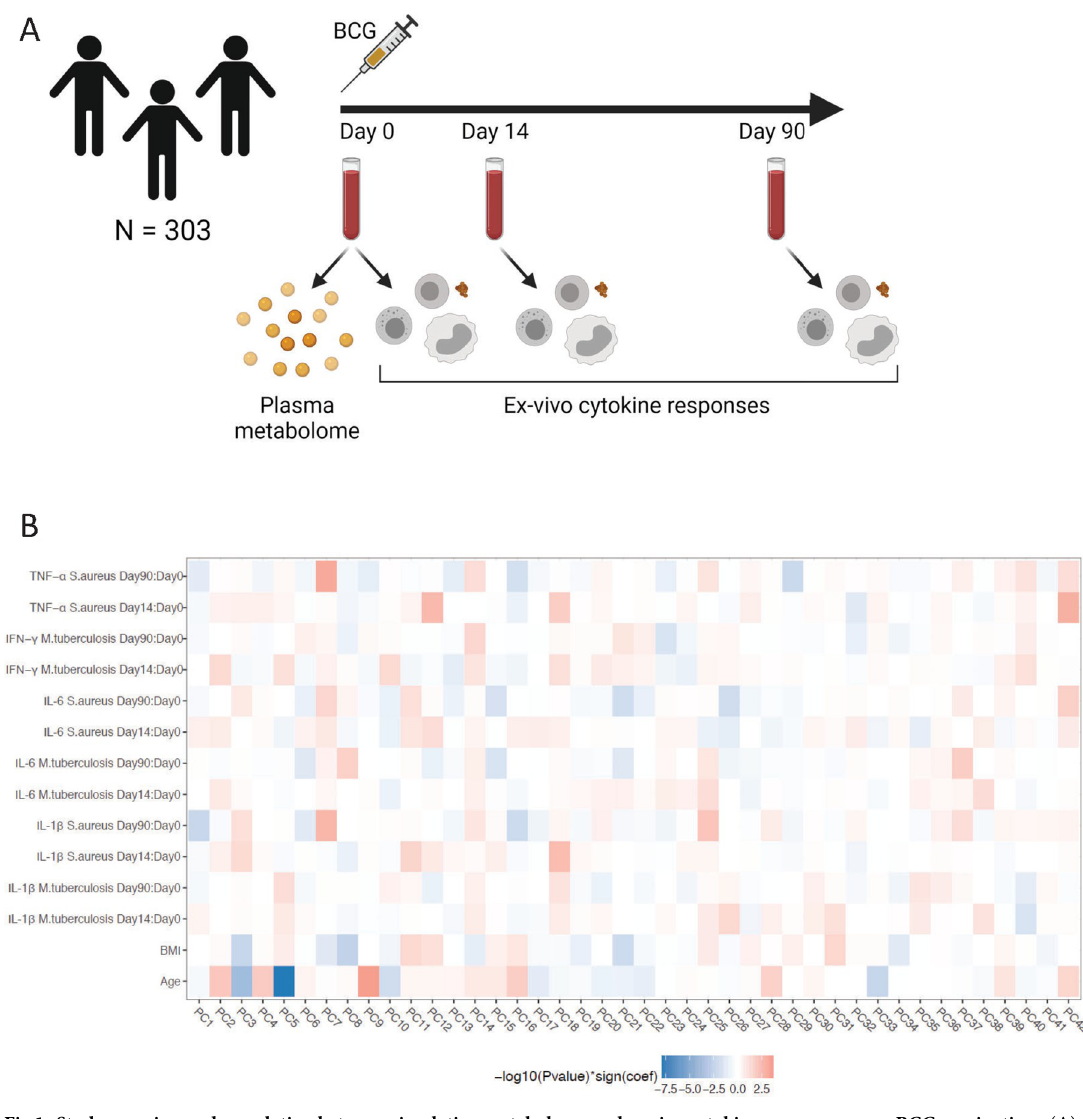
Fig 1. Study overview and correlation between circulating metabolome and ex vivo cytokine responses upon BCG vaccination. AU : AbbreviationlistshavebeencompiledforthoseusedinFigs 1 (cid:0) 5 : Pleaseverifythatallentriesarecorrect : ( A ) Schematic overview of the study. Created with BioRender.com. ( B ) Heatmap of hierarchical clustering on Spearman correlation patterns between metabolites and PBMC-derived S . aureus -induced IL-1 β , IL-6, and TNF- α responses and M . tuberculosis -induced IL-1 β , IL-6, and IFN- γ responses. The ex vivo cytokine responses are analyzed as fold changes between baseline (v1, day 0) and 2 weeks (v2, day 14) and 3 months (v3, day 90) after BCG vaccination. The metabolites are represented as the top 42 PCs, capturing 75.3% of the variance. Cell colors indicate − log 10 (p-value) multiplied by the correlation coefficients from negative (blue) to positive (red). The metadata on study participants, metabolome, and cytokine data used to generate this figure are available at https://gitlab.com/xavier-lab- computation/public/bcg300. The loadings of the top 10 metabolites of the top 10 PC’s can be found in S1 Table. BCG, Bacillus Calmette– Gue´rin; PC, principal component; PBMC, peripheral blood mononuclear